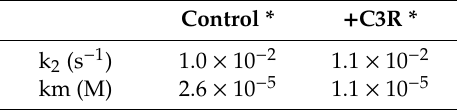
Table 2. Kinetic parameters of rhodopsin regeneration.